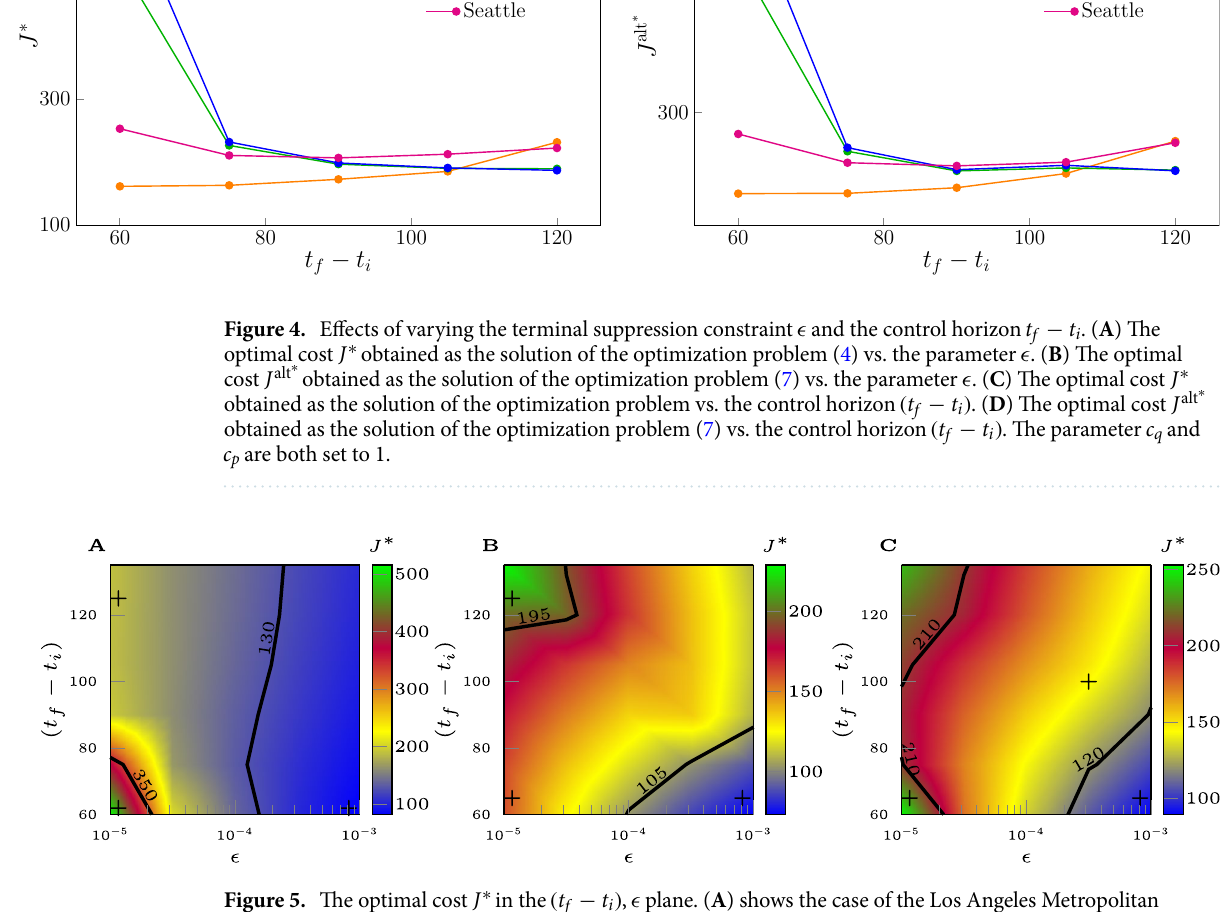
Figure 5. The optimal cost J ∗ in the ( t f − t i ) , ǫ plane. ( A ) shows the case of the Los Angeles Metropolitan Statistical Area. ( B ) shows the case of the NYC Metropolitan Statistical Area. ( C ) shows the case of the Seattle Metropolitan Statistical Area. For each city, I max is chosen as the maximum of the range in Table 3. Type 1 solutions (in green) are more expensive than type 2 solutions (in blue.) The regions in yellow/red correspond to the transition between the two types of solutions. The parameter c p and c q are both set to